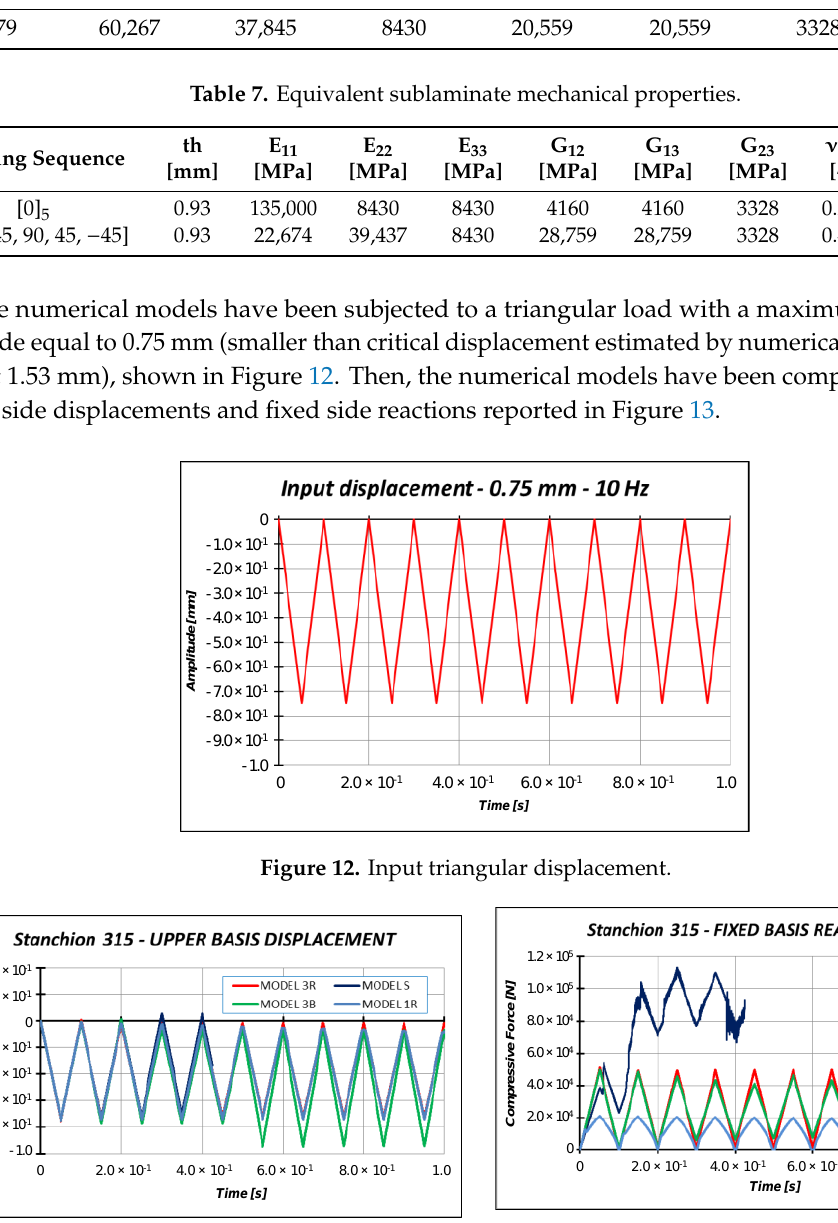
Figure 13. Free side displacement and fixed side reaction comparisons.